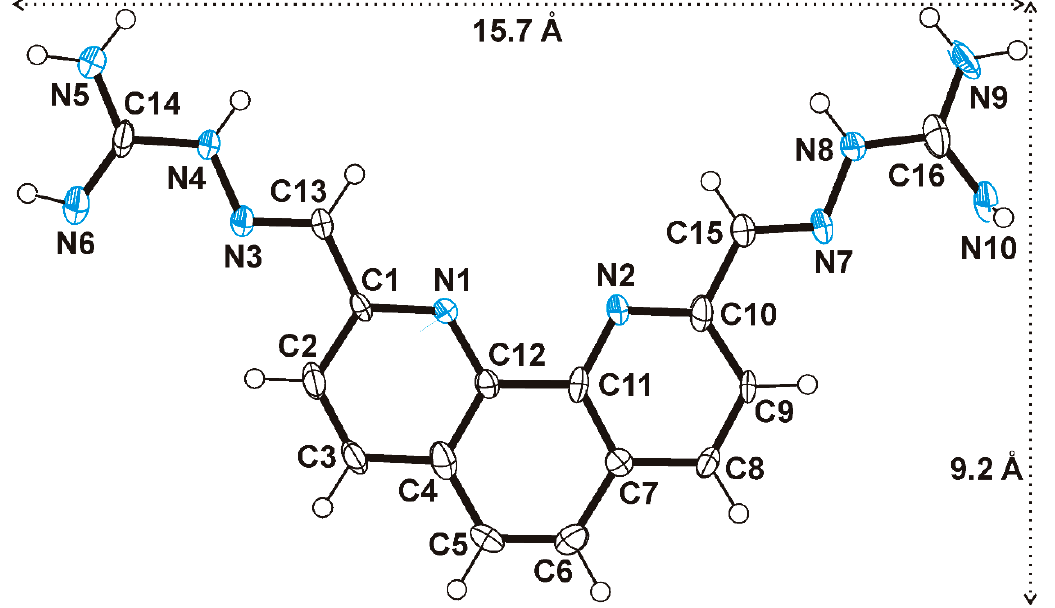
Figure 2. Ortep diagram for one of the two crystallographically independent molecules of PhenQE8. Thermal ellipsoids are drawn at the 50% probability level.